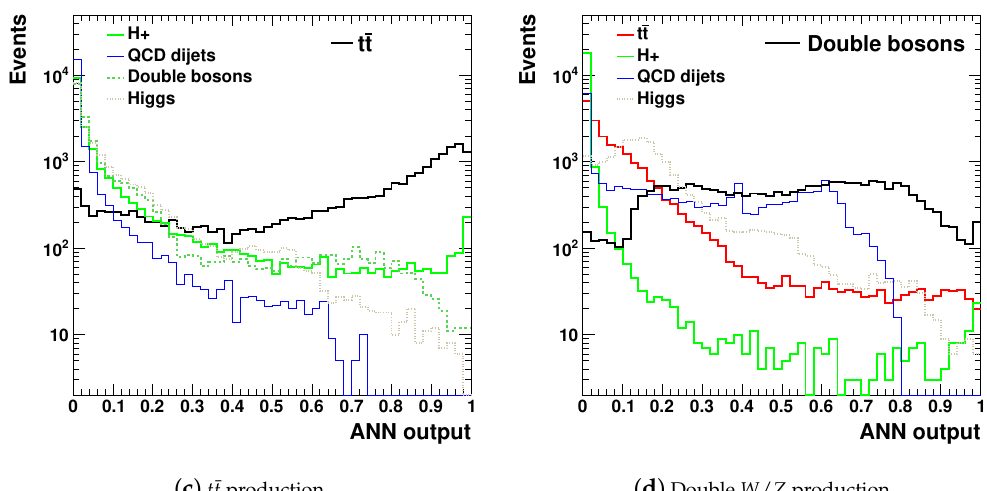
Figure 3. The ANN output scores for Monte Carlo events with the charged Higgs ( H + t ), Standard Model (SM) Higgs, t ¯ t , and double W / Z production. The black solid lines show the output for a given (known) event category. Other lines show the values of other nodes in the output ANN layer. The pp collision events were generated using Pythia8 after parton showers and hadronization. All decays of heavy bosons and top quarks allowed by the Pythia8 were